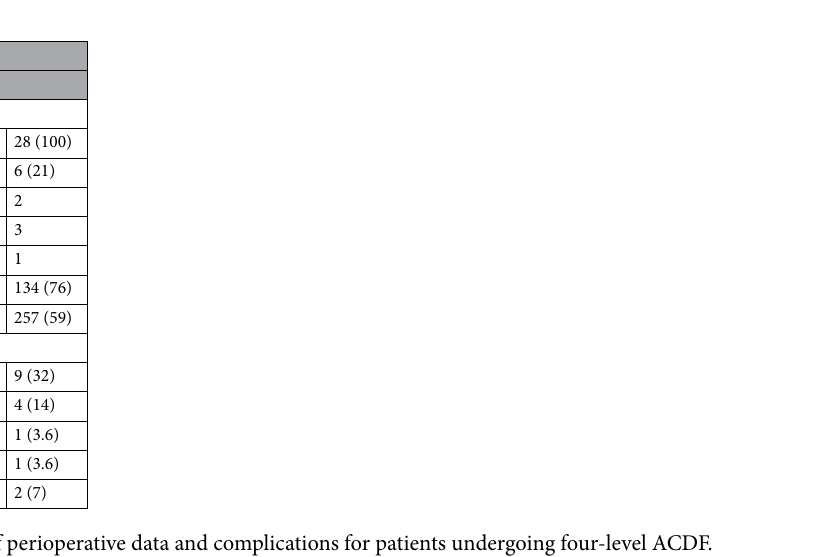
Table 2. Summary of perioperative data and complications for patients undergoing four-level ACDF. Descriptive data is presented as number (percentage) or mean (SD). ACDF anterior cervical discectomy and